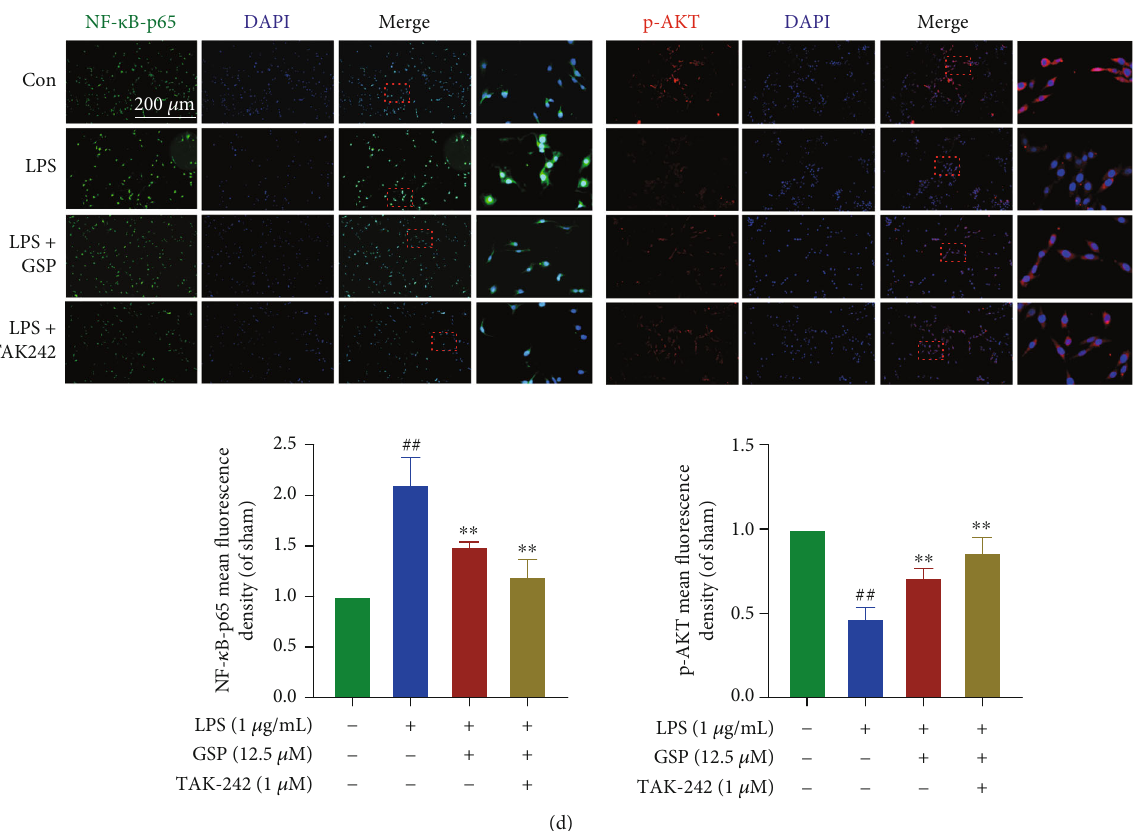
Figure 11: E ff ect of GSP on TLR4/NF- κ B/PI3K/AKT signaling cascades in vitro . (a) E ff ects TAK242 on cell viability. (b) Representative WB and quantitative analysis of CD86 and Arg-1. (c) Representative WB and quantitative data of TLR4/MyD88/NF- κ B/PI3K/AKT signaling cascades in each group. (d) IF and quantitative data of p-NF- κ B-p65 and p-AKT in each group. ## p < 0 : 01 vs. control group. ∗∗ p < 0 : 01 vs. LPS-treated